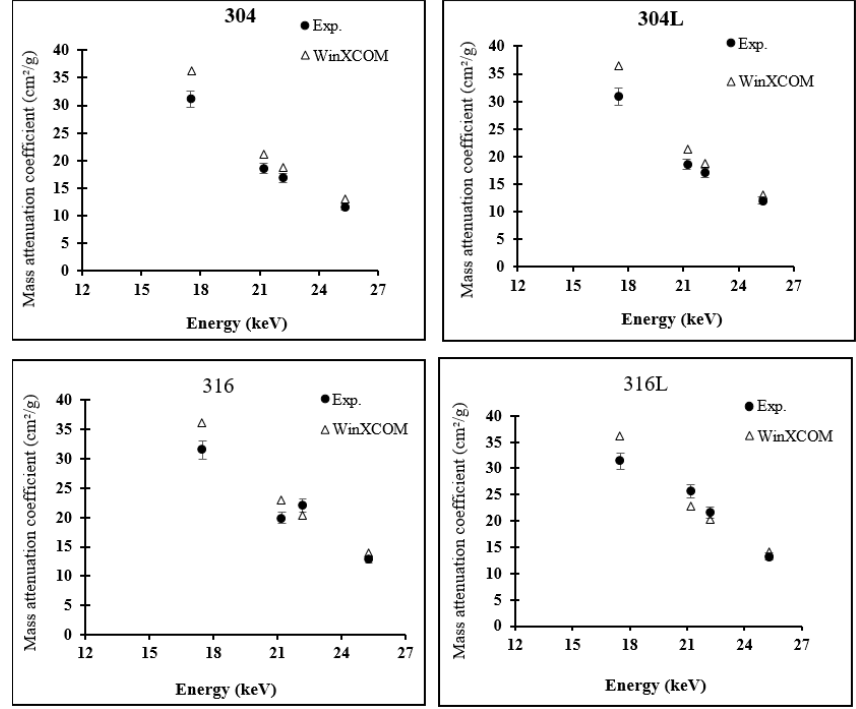
Figure 2. Comparison of mass attenuation coefficients for all four stainless-steel samples evaluated experimentally and calculated theoretically using